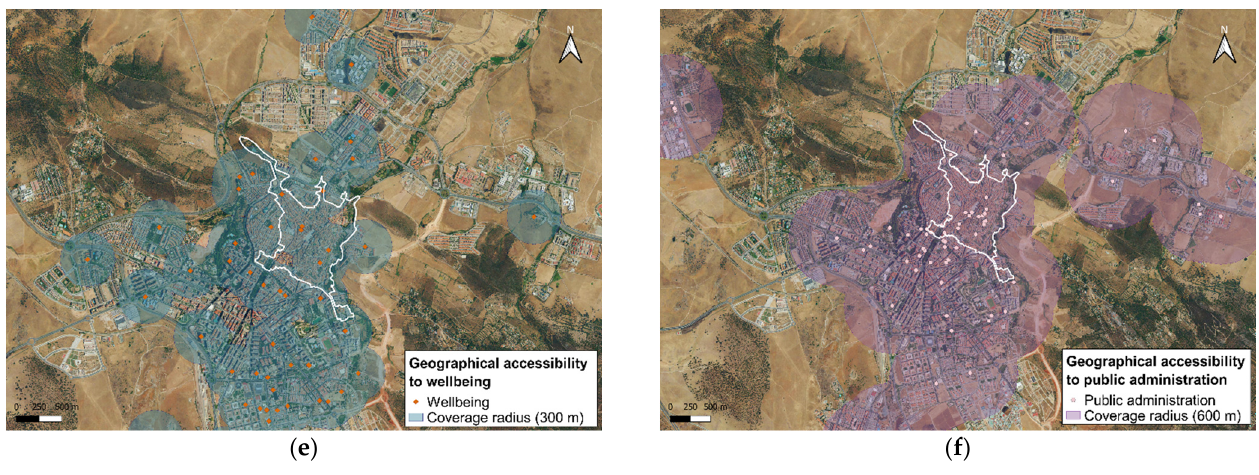
Figure 9. Maps of accessibility to state-funded public services: ( a ) cultural facilities; ( b ) sports centres; ( c ) schools and education; ( d ) health centres; ( e ) wellbeing; public administration.